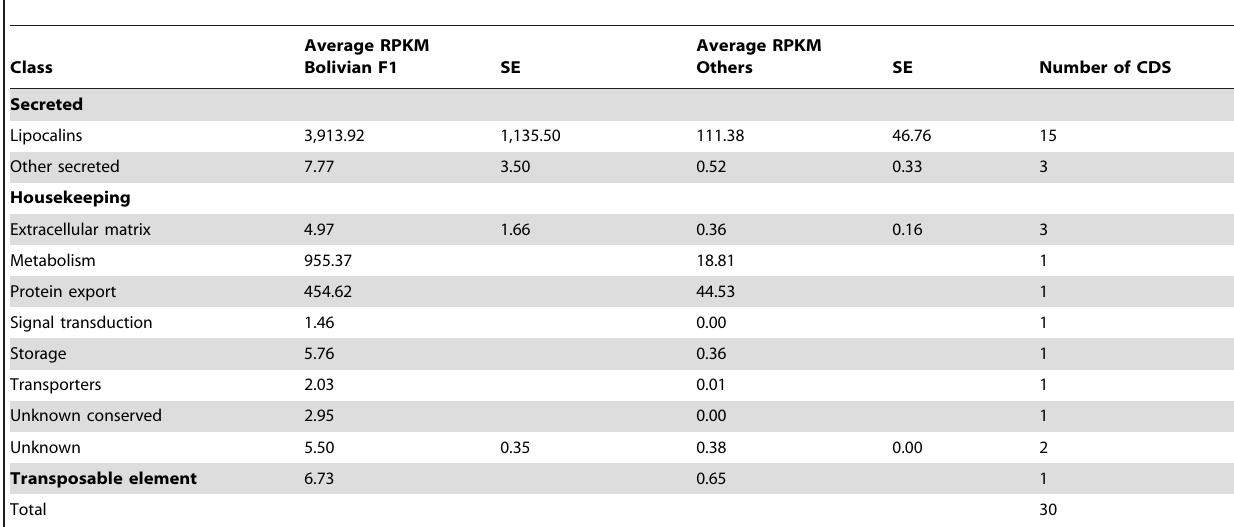
Table 9. Transcripts found overexpressed ( . 10 fold) on Bolivian F1 population.